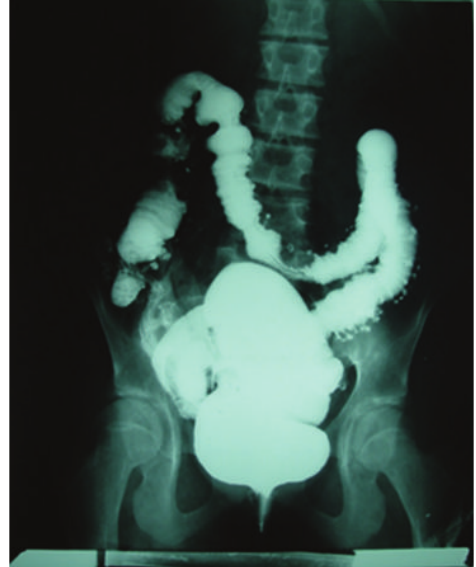
Figure 3: Barium enema of the patient revealed diverticulosis of the sigmoid colon and left